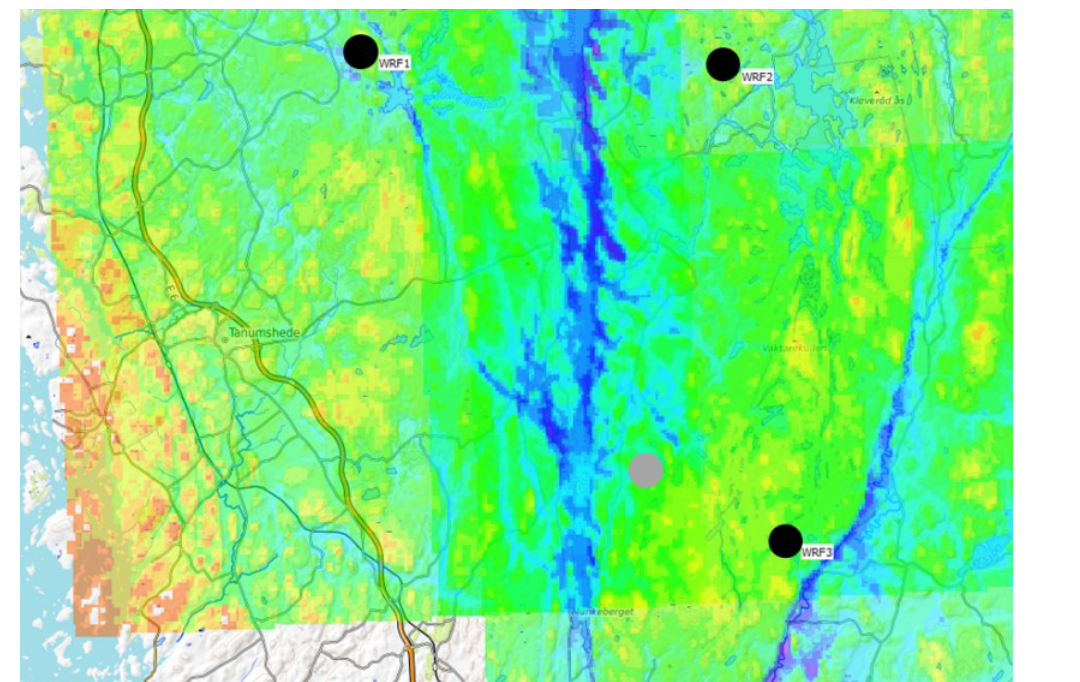
Figure 3. Illustration of the MTLA method where the wind speed at the target location (grey marker) is predicted based on three separate ME-WAM analyses. The black markers indicate the data transfer locations. The colour scale in the background represents mean wind speed at 100ma . g . l . , red represents high wind, and blue represents low wind in a range from 5 to 8ms − 1